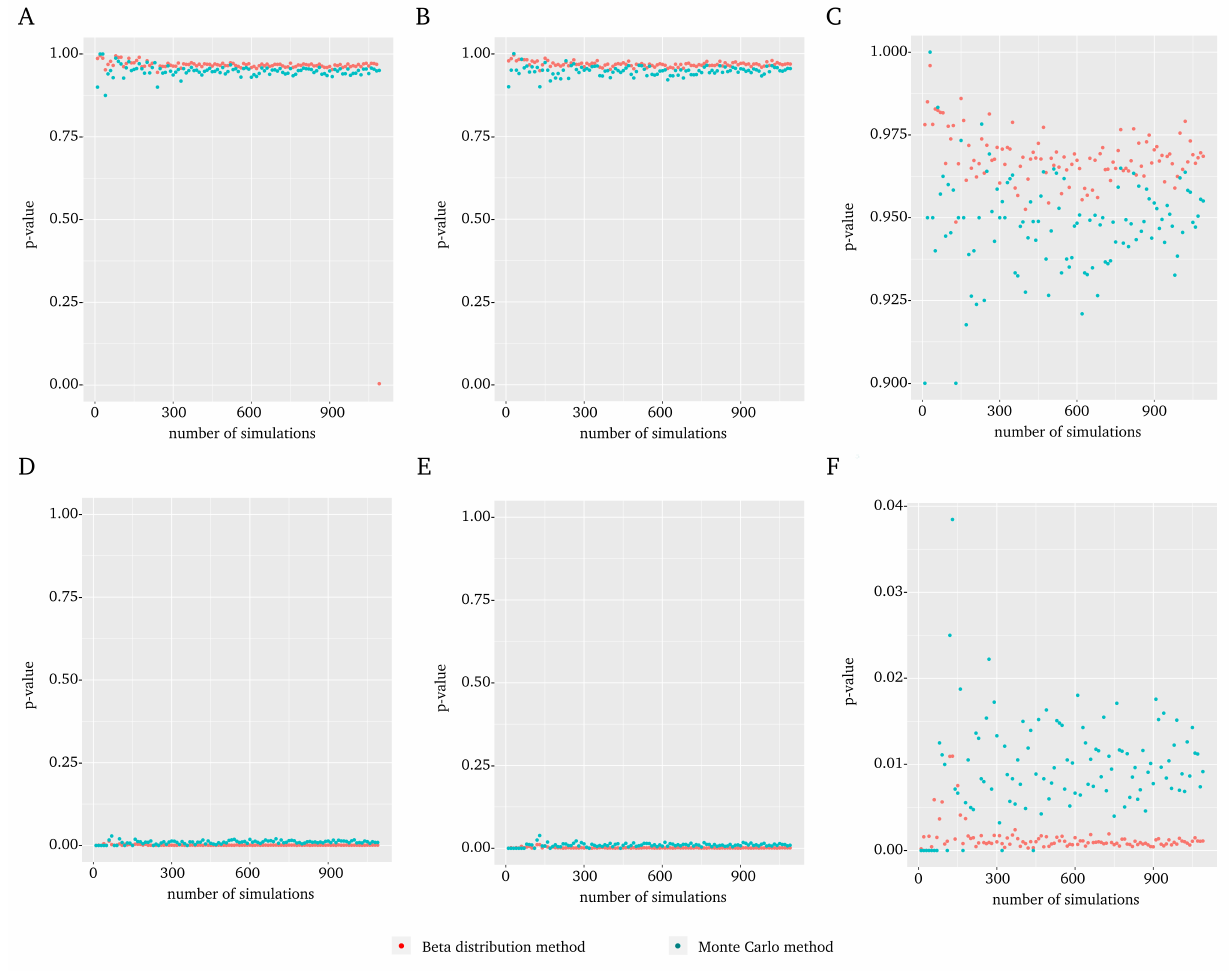
Figure 1. Comparison between the score and Montecarlo p -value using MYC gene results in the GSE110223 dataset as an example. For each plot, the Montecarlo p -value (blue) and the score (red) are displayed with respect to the number of randomizations. ( A ) Results obtained using the t-Student distribution and between-pair randomization. ( B ) Results obtained using normal distribution and between-pair randomization. ( C ) The plot shown in ( B ), using an enlarged scale to highlight the upper range. ( D ) Results obtained using t-Student distribution and complete randomization. ( E ) Results obtained using normal distribution and complete randomization. ( F ) The plot shown in ( E ), using an enlarged scale to highlight the lower